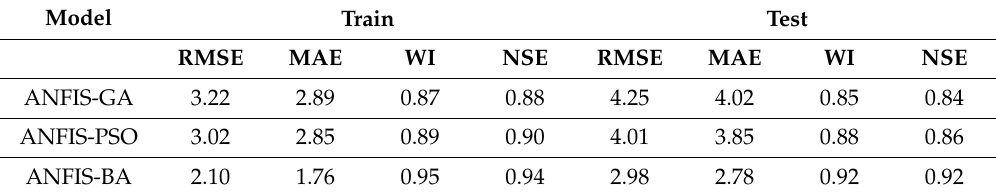
Table 6. Di ff erent indexes for evaluation of di ff erent ANFIS models (unit for RMSE and MAE : ◦ C).